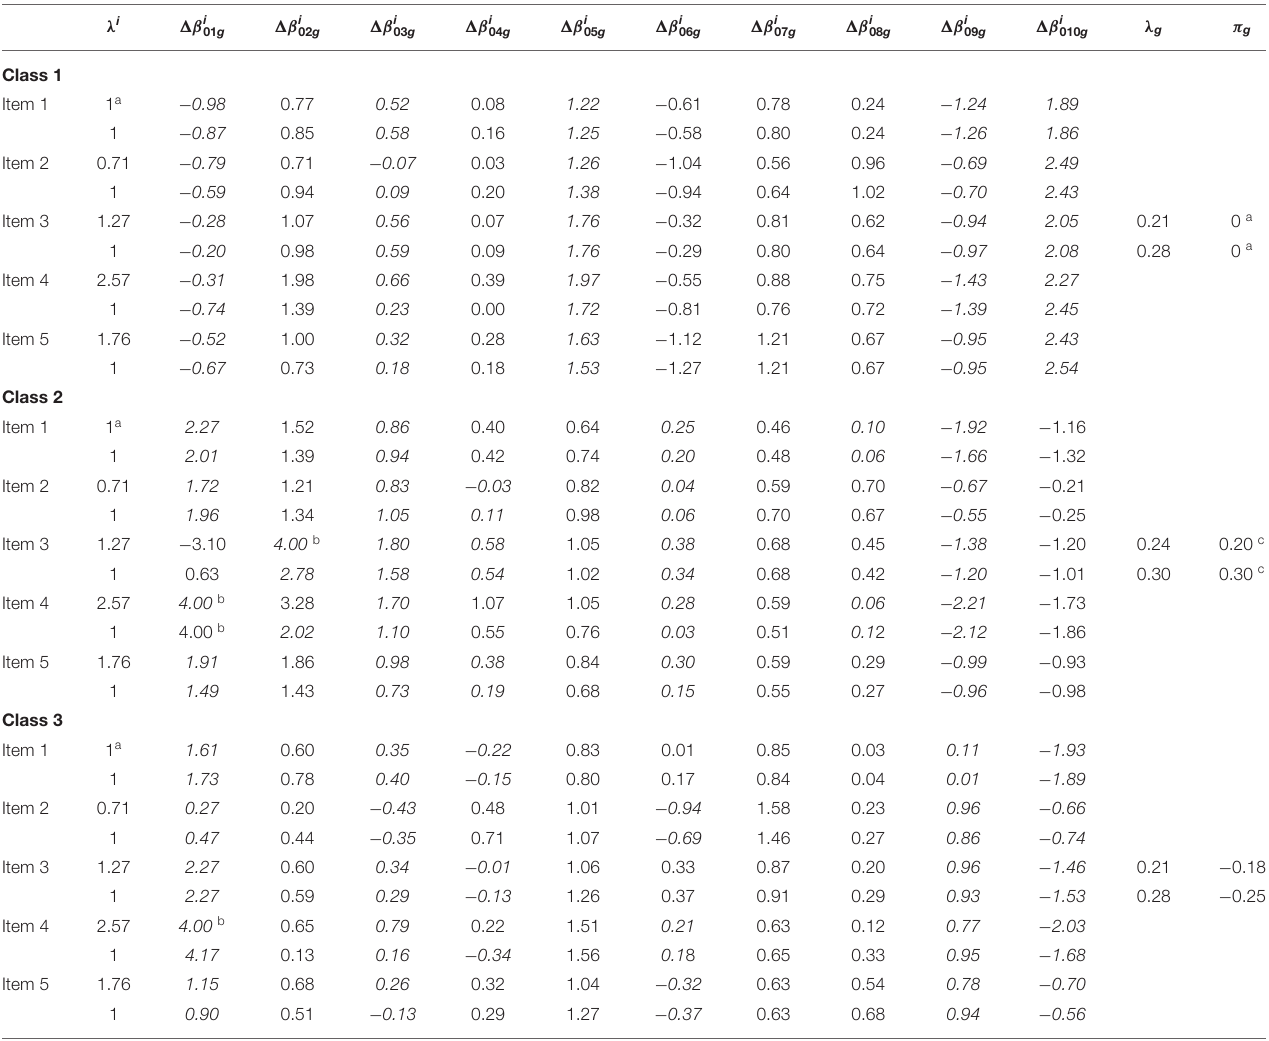
TABLE 2 | Generating parameters of the rmGPCM-3 (upper lines) and the mPCM-3 (bottom lines). λ